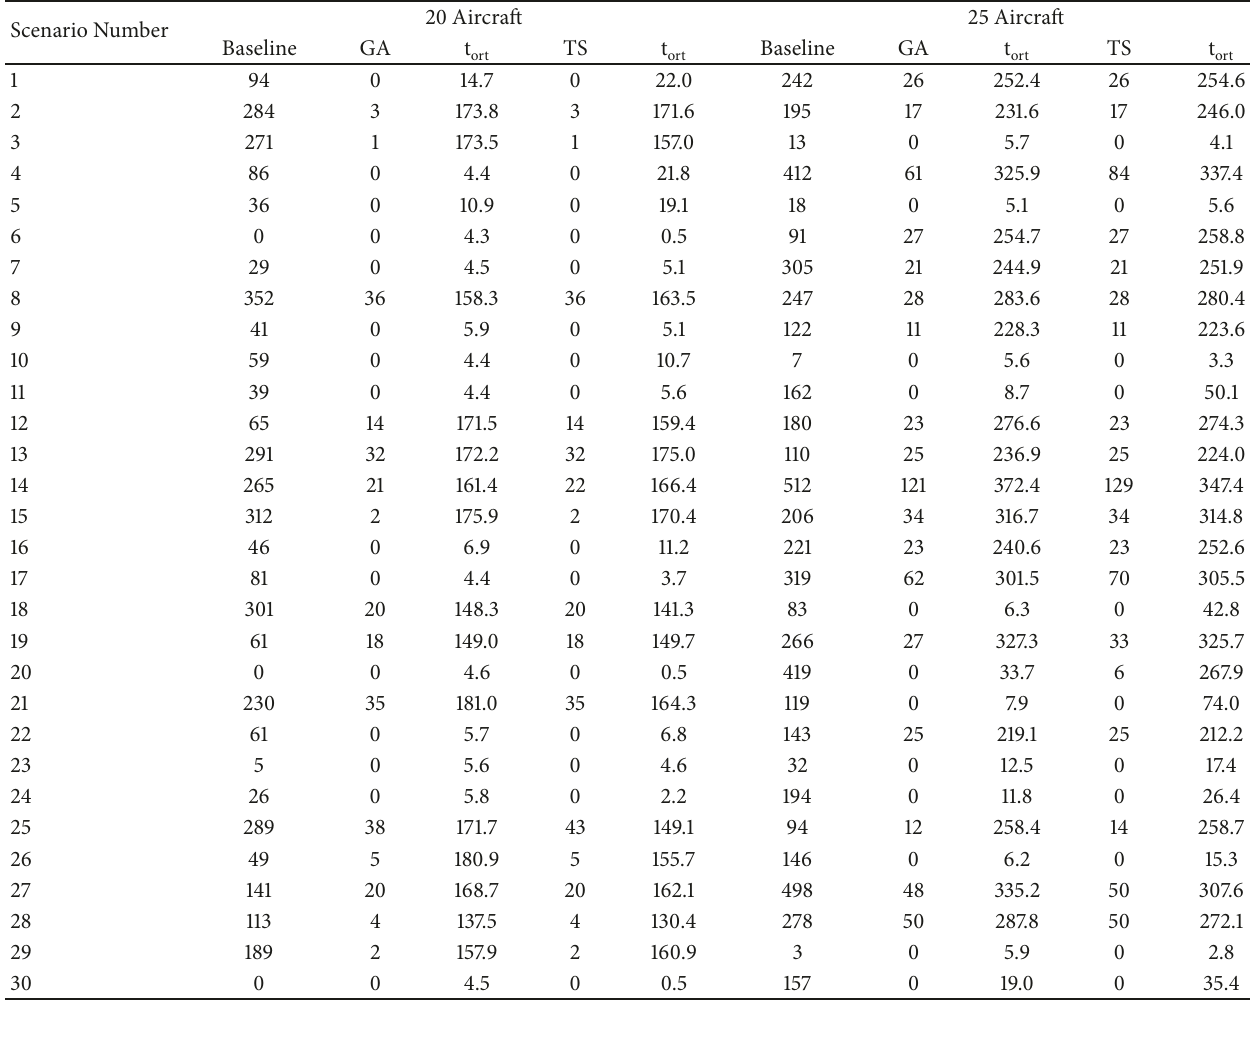
Table 9: The airborne delays (sec.) and CPU times (sec.) of the all scenarios with 20 and 25 aircraft per hour. Scenario Number